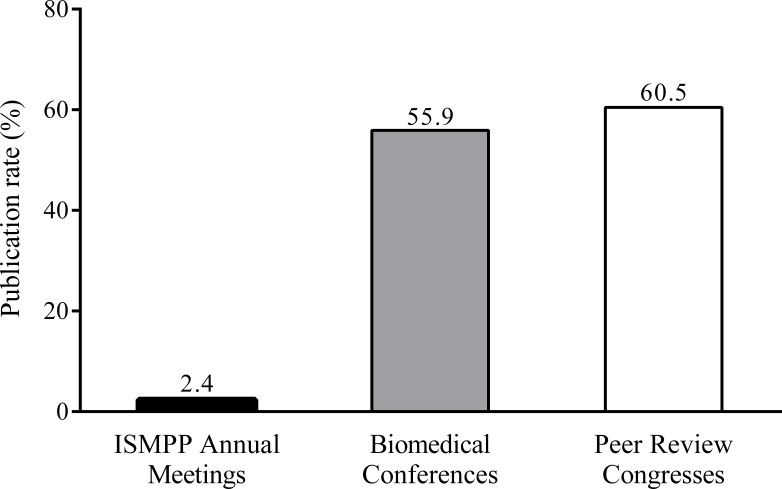
Low publication rates from ISMPP Annual Meetings versus publication rates from biomedical conferences (Scherer et al., 2015) and Peer Review Congresses (Malički, Von Elm & Marušic, 2014).Abbreviation: ISMPP, International Society for Medical Publication Professionals.